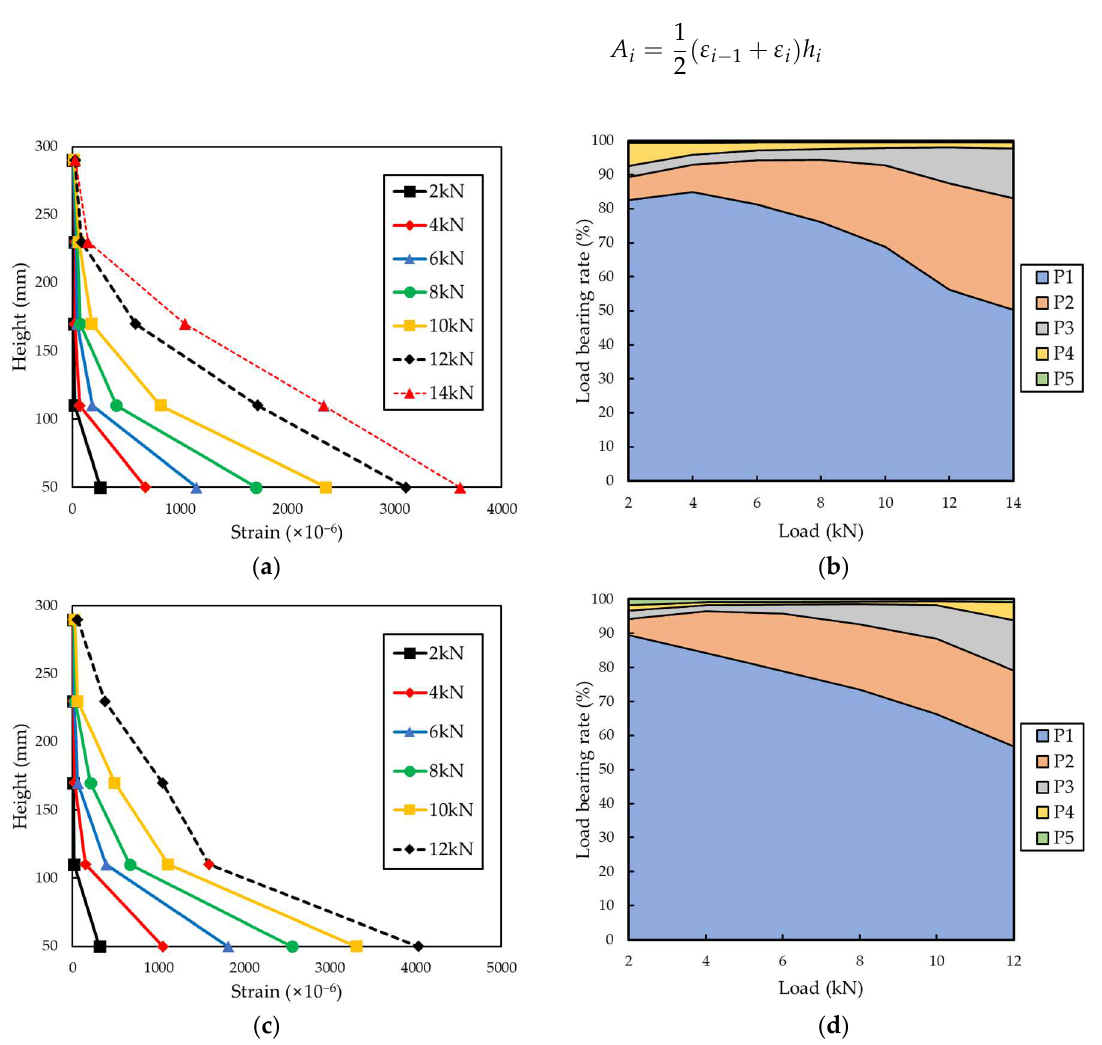
Figure 10. Tensile strain distribution and load-bearing rate of each point of H.C-1 and I.C-2. ( a ) Tensile strain distribution of H.C-1. ( b ) Load-bearing rate of each point of H.C-1. ( c ) Tensile strain distribution of I.C-2. ( d ) Load-bearing rate of each point of